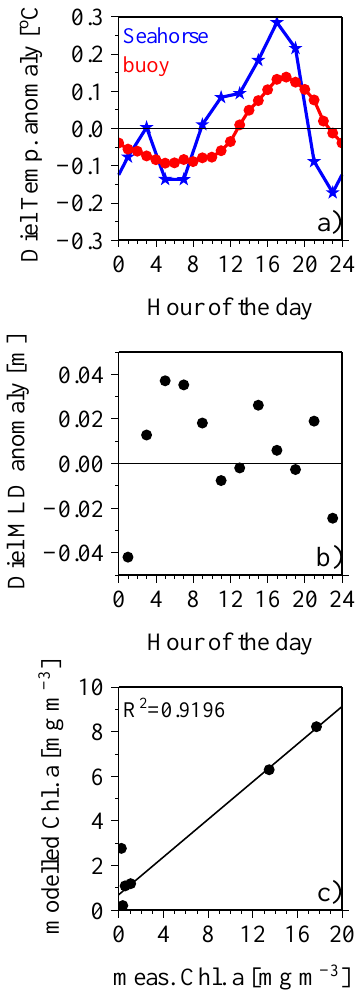
Fig. 2. (a) Comparison of the diel temperature anomaly recorded by the CARIOCA buoy (red) and the SeaHorse profiler (blue), shown as average of the days 160–200. (b) Diel MLD anomaly, shown as average of the days 160–200, computed from the maximum of the Brunt-V¨ais¨al¨a frequency as measure of the MLD. (c) Correlation between the Chl a concentrations measured and modelled after Na- horniak et al.